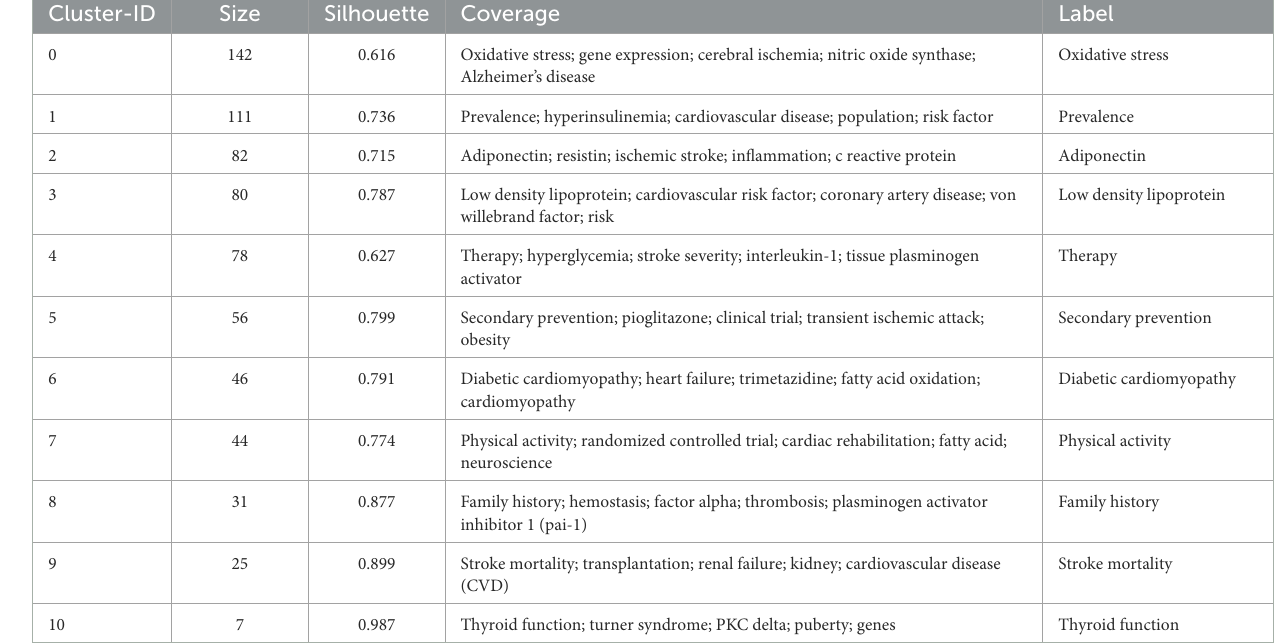
TABLE 6 Keywords cluster